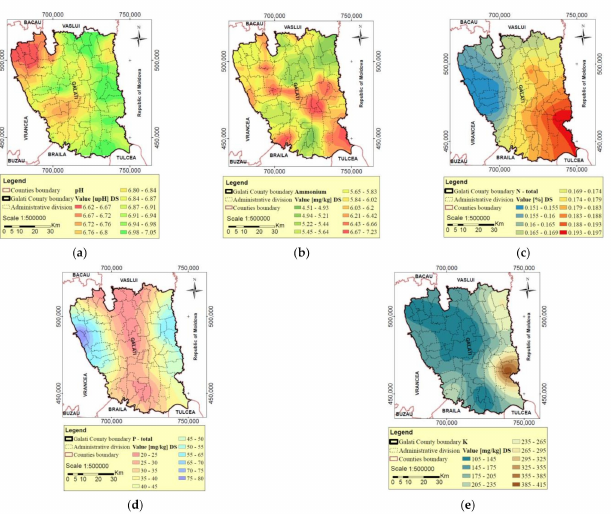
Figure 4. Dispersion model on the agricultural lands in Galati County: pH ( a ); NH 4+ ( b ); N-total ( c ); P-total ( d ); kalium ( e ).